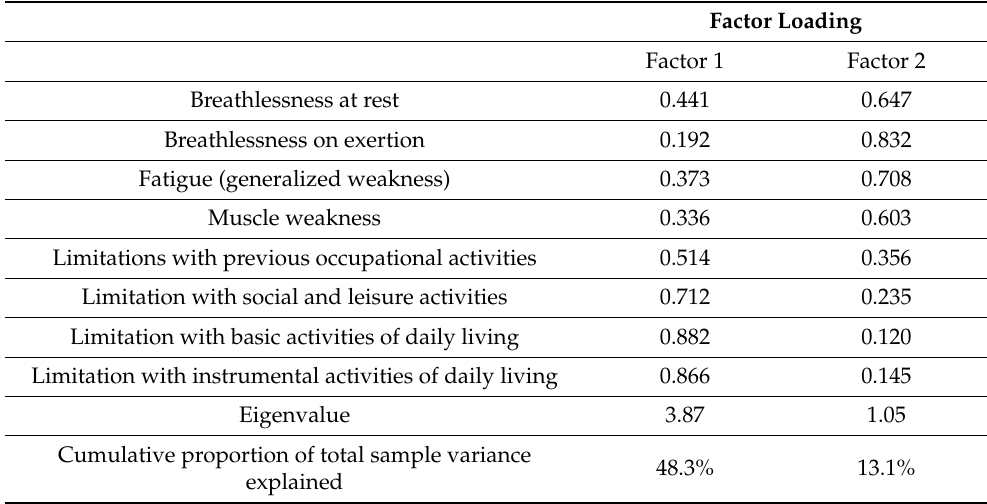
Table 3. Exploratory Factor Analysis of each item of the Functional Impairment Checklist (FIC) in COVID-19 survivors experiencing